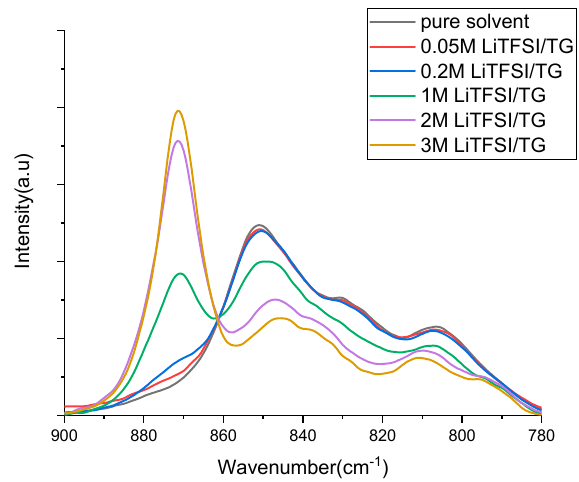
Figure 1. Raman spectra recorded for di ff erent concentrated electrolytes of LiTFSI / TG (Tetraglyme).